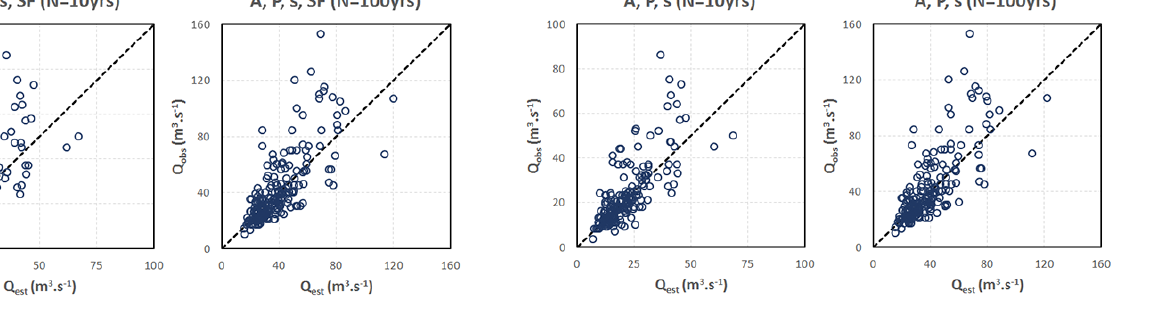
Figure 13. Scatterplot of observed versus estimated discharge val- ues for a combination of catchment area, maximum daily precipita- tion total and average catchment slope for T = 10 years (left panel) and T = 100 years (right panel).